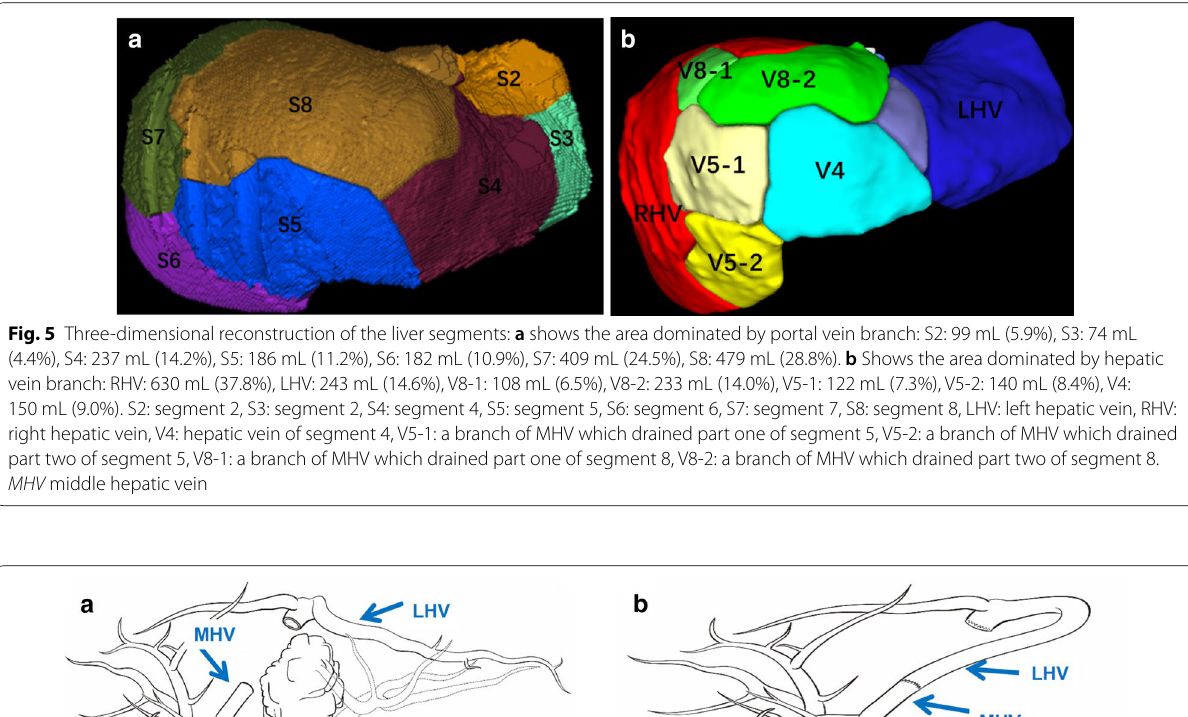
were removed. The left portal vein was used as a vein graft to reconstruct the middle hepatic vein (Fig. 10). Postoperative ultrasound showed the reconstructed vein was patent (Fig. 11). The operation time was 600 min, the blood loss was 300 mL. The pathological findings showed: moderately differentiated intrahepatic cholangiocarcinoma, the resection margin of MHV was 1 cm from tumor, no microvascular invasion was seen. No metastasis was found in lymph node of No. 8, 9, 12, 13a. The patient was regularly followed in outpa - tient clinic and there was no recurrence evidence and complications. The follow-up was 2 years and 6 months until now.